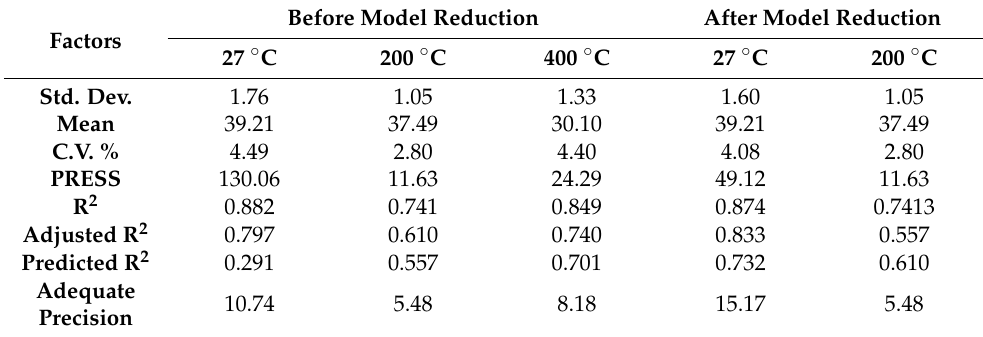
Table 8. Coefficient of determination for residual compressive strength